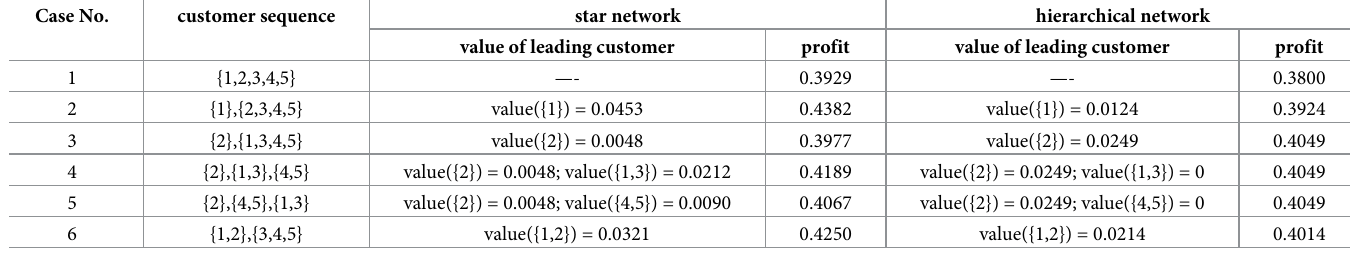
Table 1. The values of the leading customer sets under different customer sequences. Case